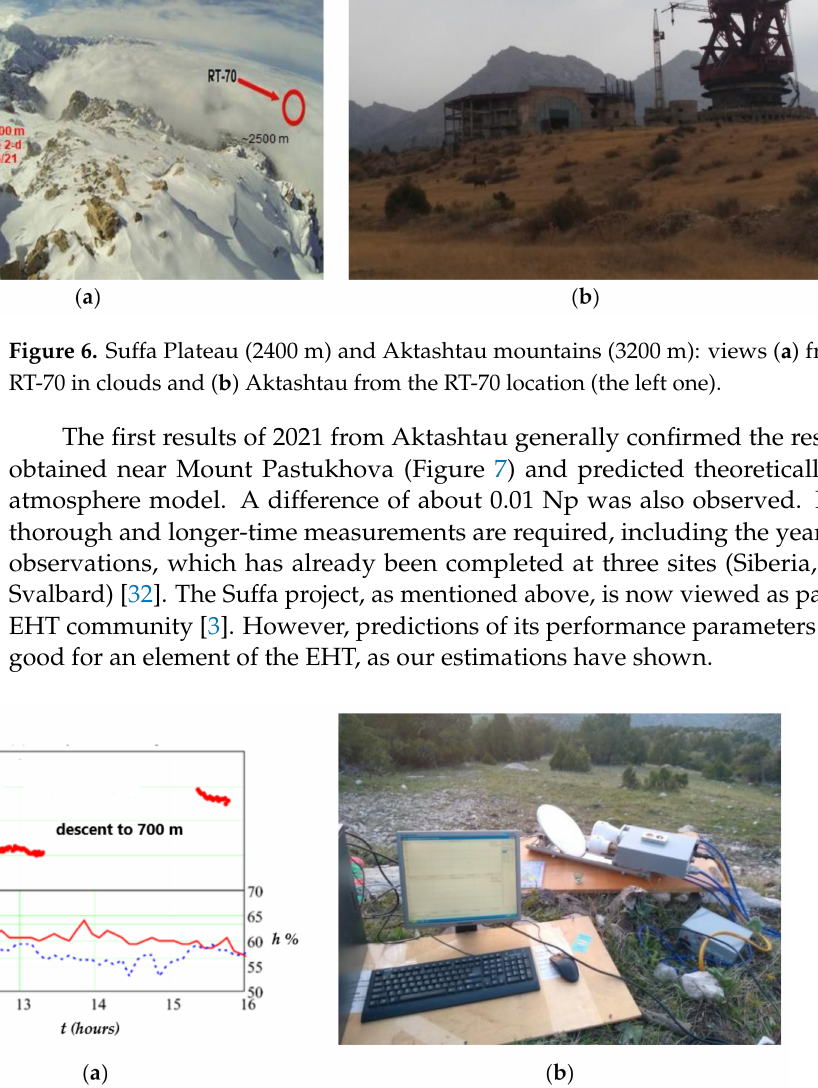
Figure 7. ( a ) Difference of τ (Np) between two points near Mount Pastukhova differing in altitude by 700 m [25]. Measurements of τ were performed over ~3.5 h at 12:15–15:45 (top picture) at relatively low temperature (red, bottom) and humidity (blue dots) variations. ( b ) Measurements at Aktashtay slope (2900 m) June 2021 by MIAP-2 confirmed possibility to install a small (15–21 m) antenna of the Suffa